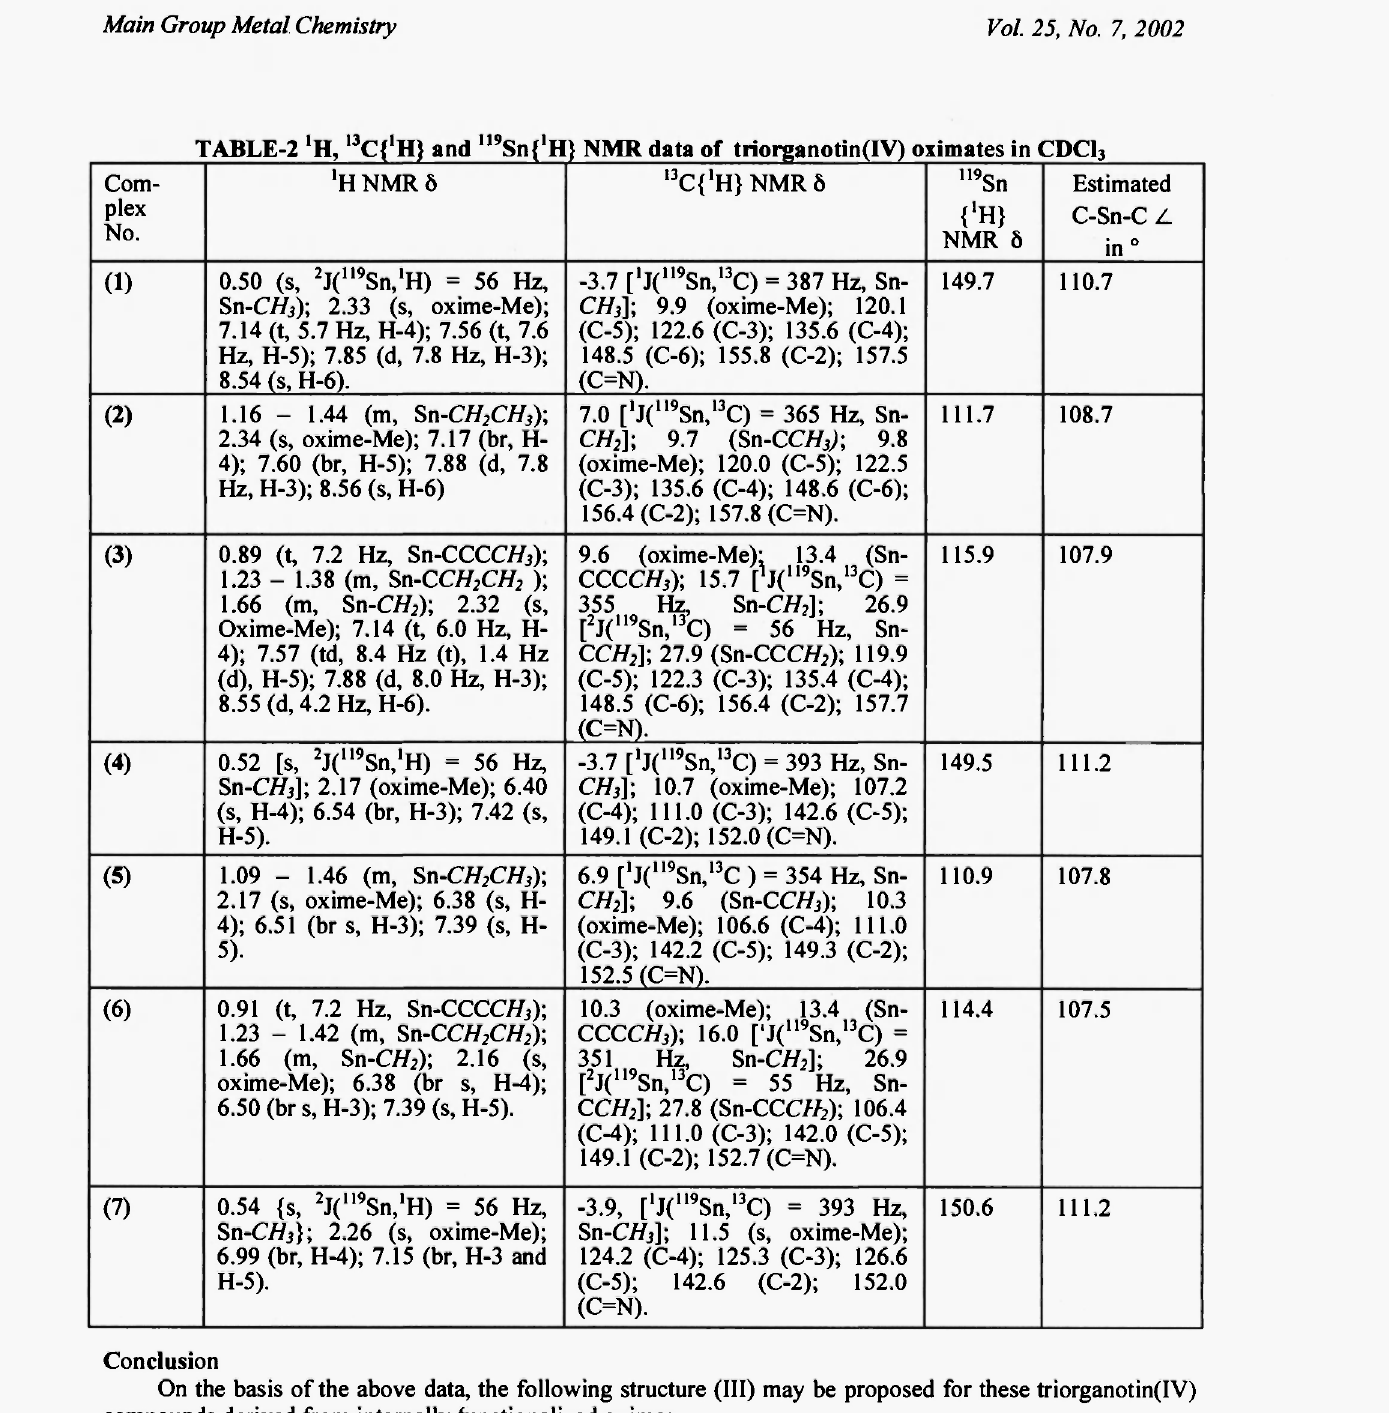
TABLE-2 'H, 13 C{'H} and '"Snf'H} NMR data of triorganotin(IV) oximates in CPC1